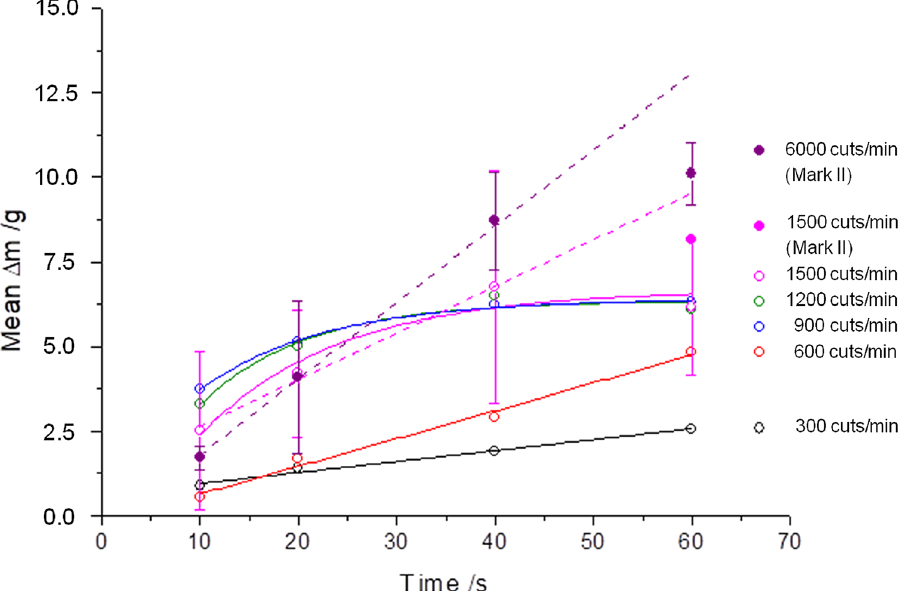
Figure 6. The technological progress of the new handpiece Mark II is shown by the increase in the aspiration rate at 1500 cuts/min and 60 s irradiation time. Furthermore, 6000 cuts/min are now